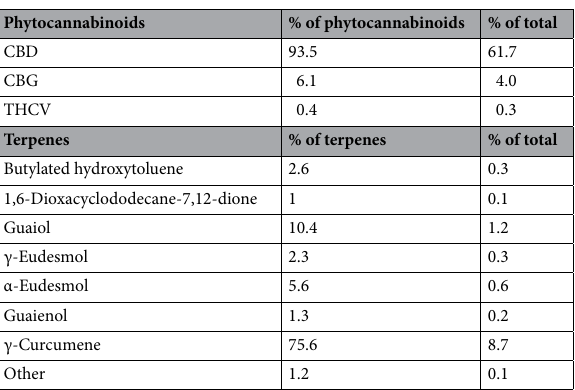
Table 1. Terpene and phytocannabinoids composition in F CBD as a percentage of total phytocannabinoids/ terpenes and as a percentage of total compounds in extract.